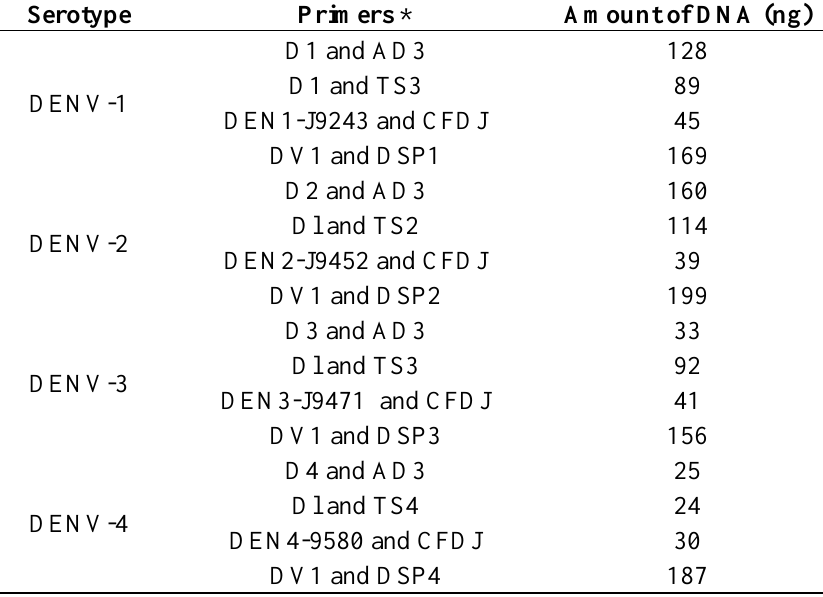
Table 3. Amplicon quantification by densitometry.